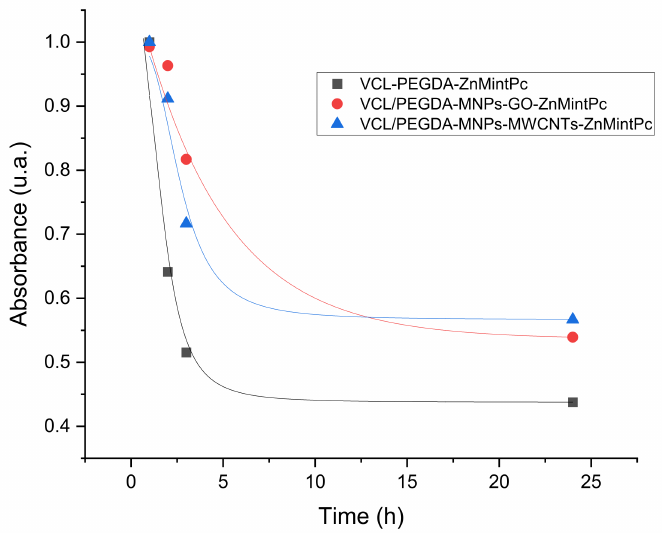
Figure 5. Decay curves of: VCL-PEGDA-ZnMintPc, VCL/PEGDA-MNPs-MWCNTs-ZnMintPc and VCL/PEGDA-MNPs-GO-ZnMintPc. ZnMintPc = 0.27 µ